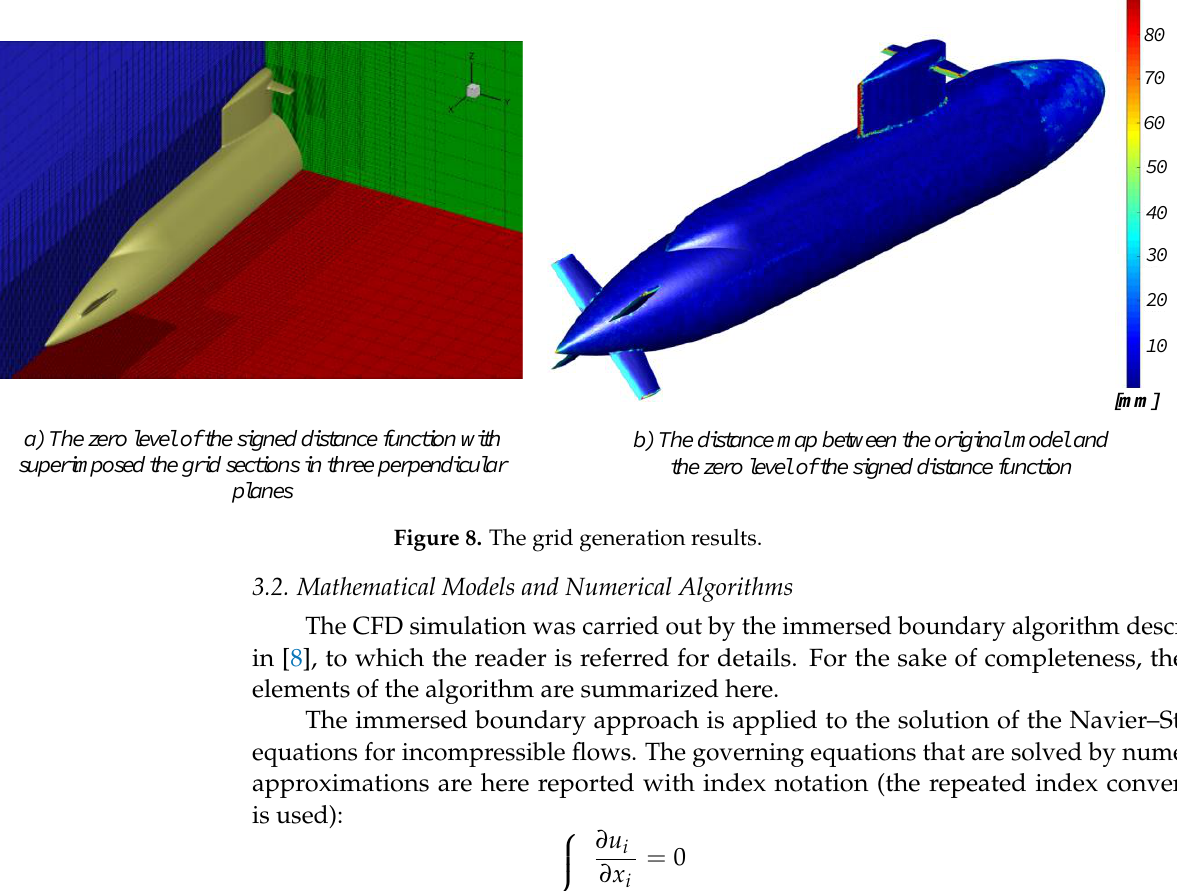
Figure 7. The segmented model with window-based boxes refinement.